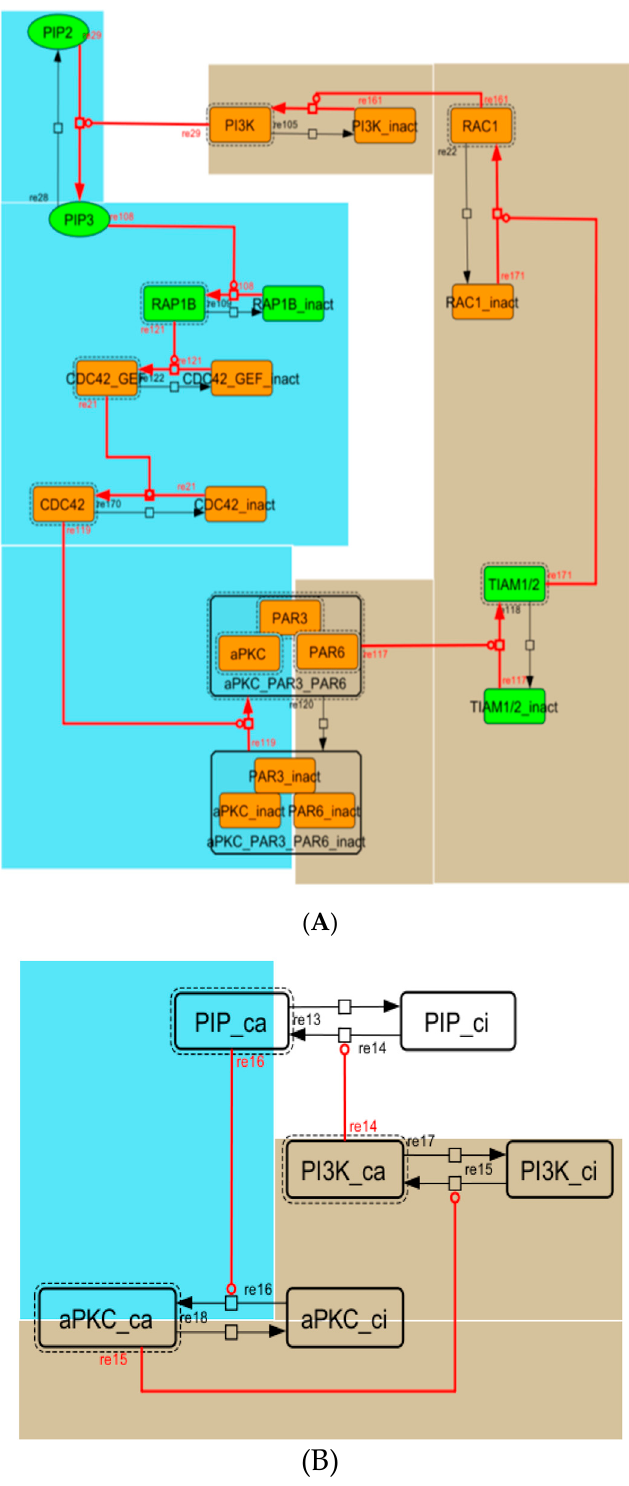
Figure A4. Diagram of the positive-feedback loop between PI3K and aPKC_PAR3_PAR6. ( A ) The positive-feedback loop in the whole signaling network. ( B ) The contracted positive-feedback loop in the toy model. Red edges represent positive regulations. Background colors show correspondence relationships between before and after contraction .